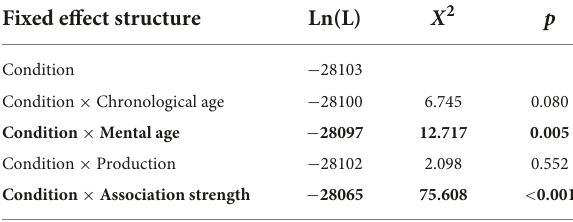
TABLE 6 Fit comparison of demographic models for the DS group.